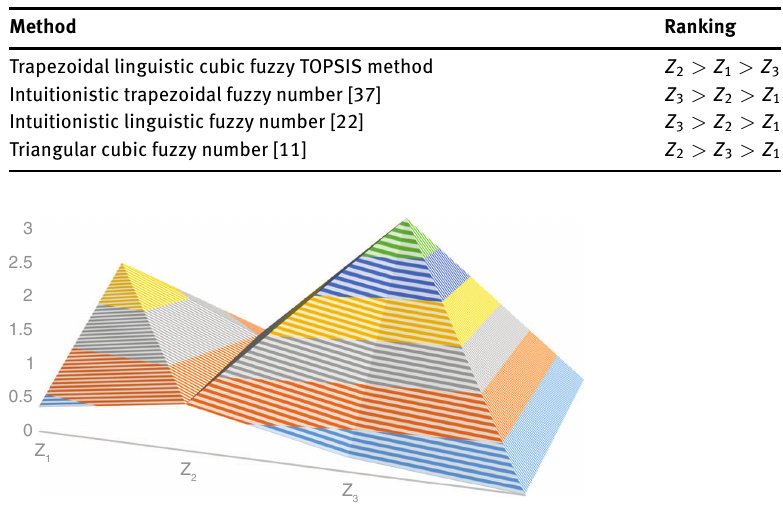
Table 13: Triangular Cubic Fuzzy Hybrid Aggregation Operator. B 1